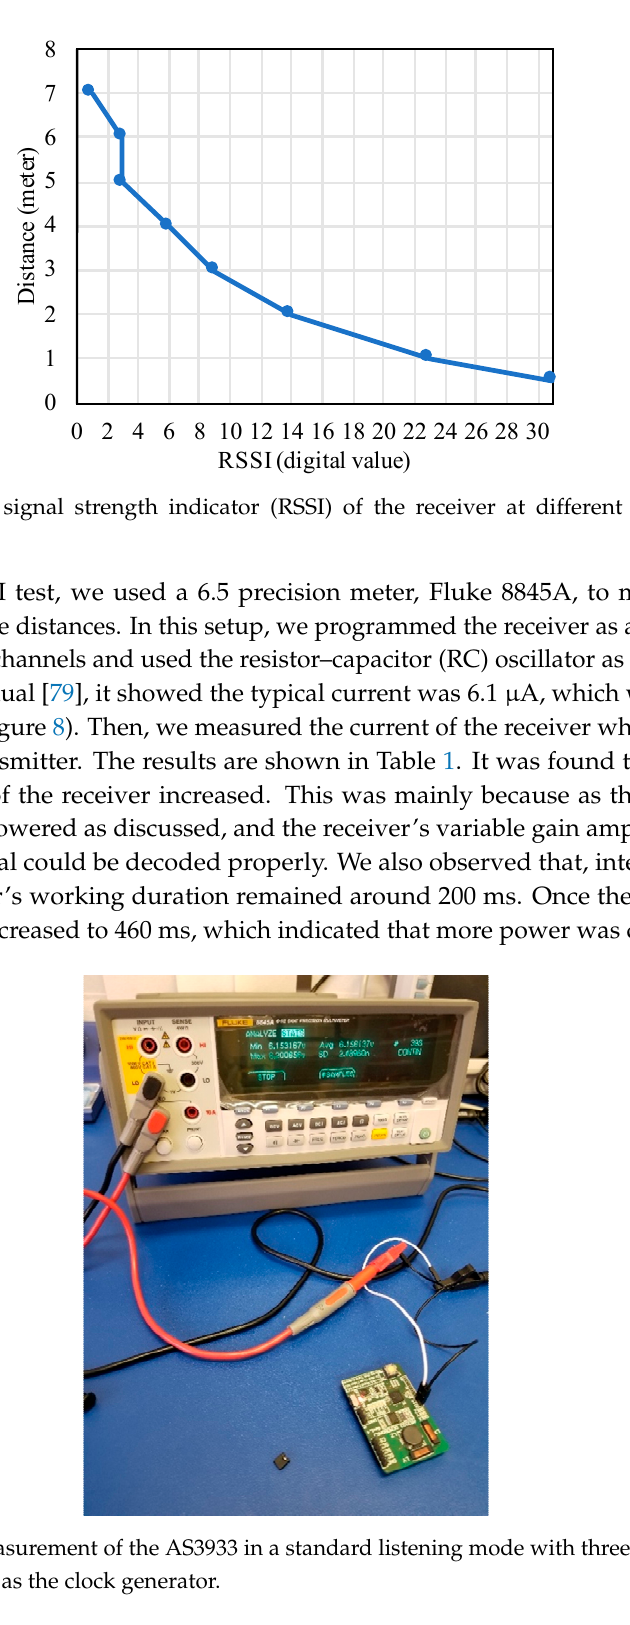
Figure 8. Current measurement of the AS3933 in a standard listening mode with three active channels and the RC-oscillator as the clock generator.